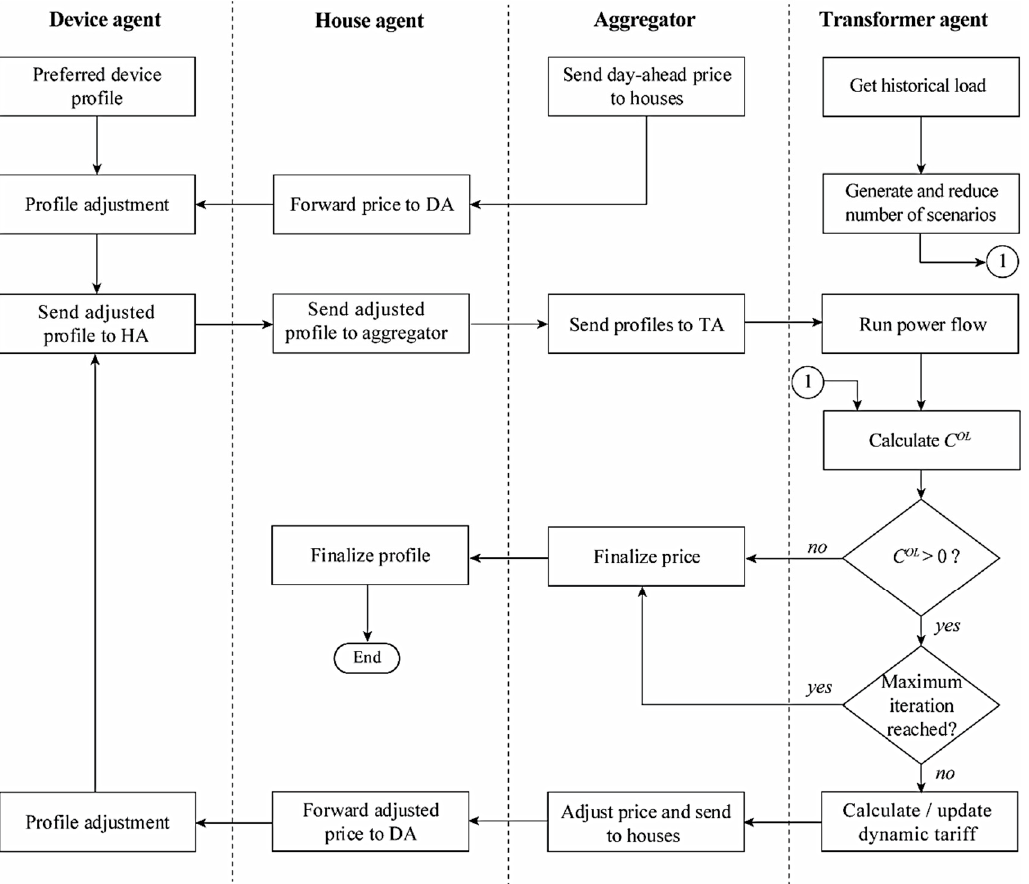
Figure 4. Flowchart depicting the processes.